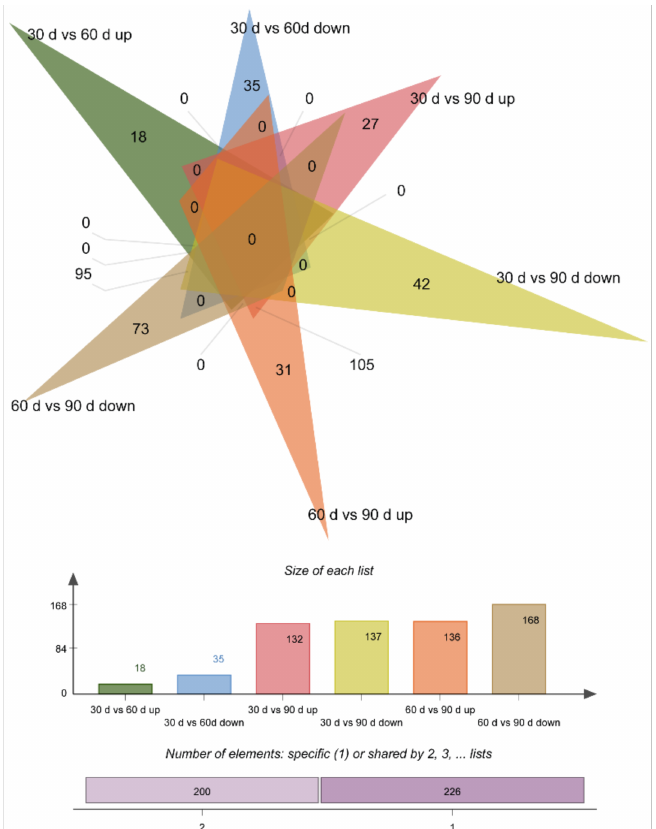
Figure 7. Venn diagram of DEPs. In the Venn diagram, each triangle represents the differential proteins in a comparison combination (30 d vs. 60 d, 30 d vs. 90 d, and 60 d vs. 90 d), the number of overlapping triangular regions represents the number of common differential genes among the corresponding comparison combinations, and the non-overlapping region represents the unique differential genes in each comparison. A histogram corresponding to the Venn diagram can identify upregulated and downregulated DEPs in each comparison. Venn results showed that 60 d vs. 90 d had the maximum number of DEPs (304), and 30 d vs. 90 d (269) and 30 d vs. 60 d had the lowest number of DEPs (53).